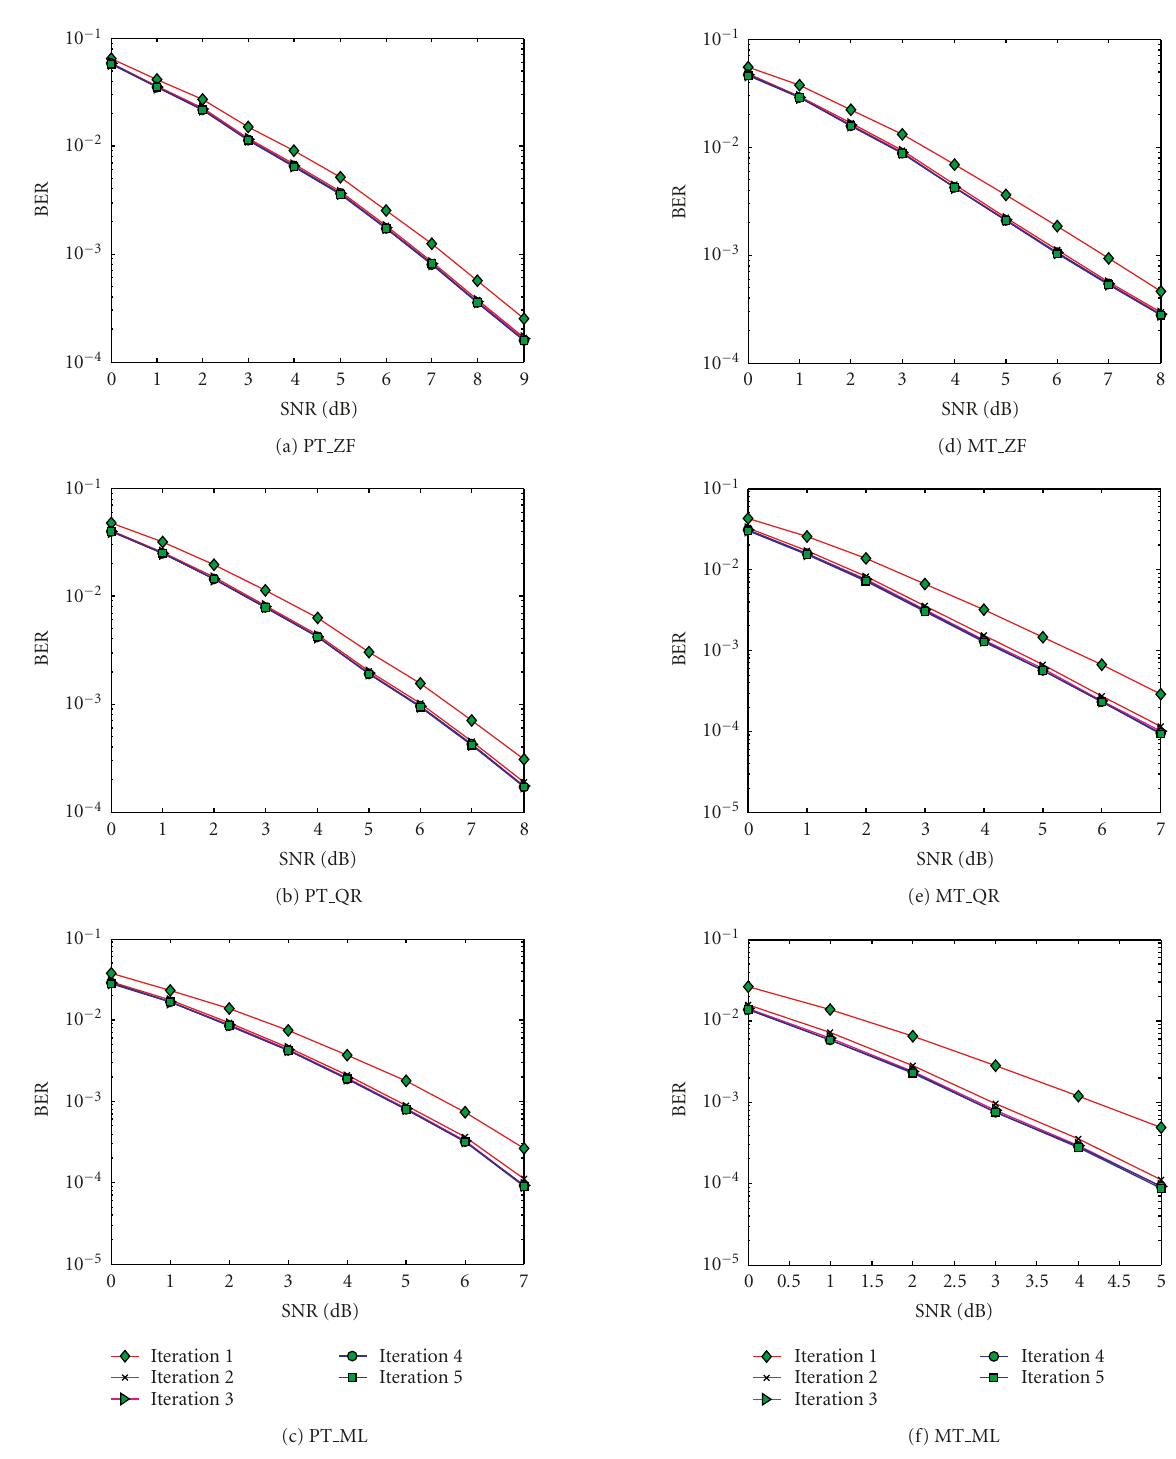
Figure 13: BER versus SNR for di ff erent iterations (SNR in = SNR + 10dB and SNR rd = SNR + 5dB).